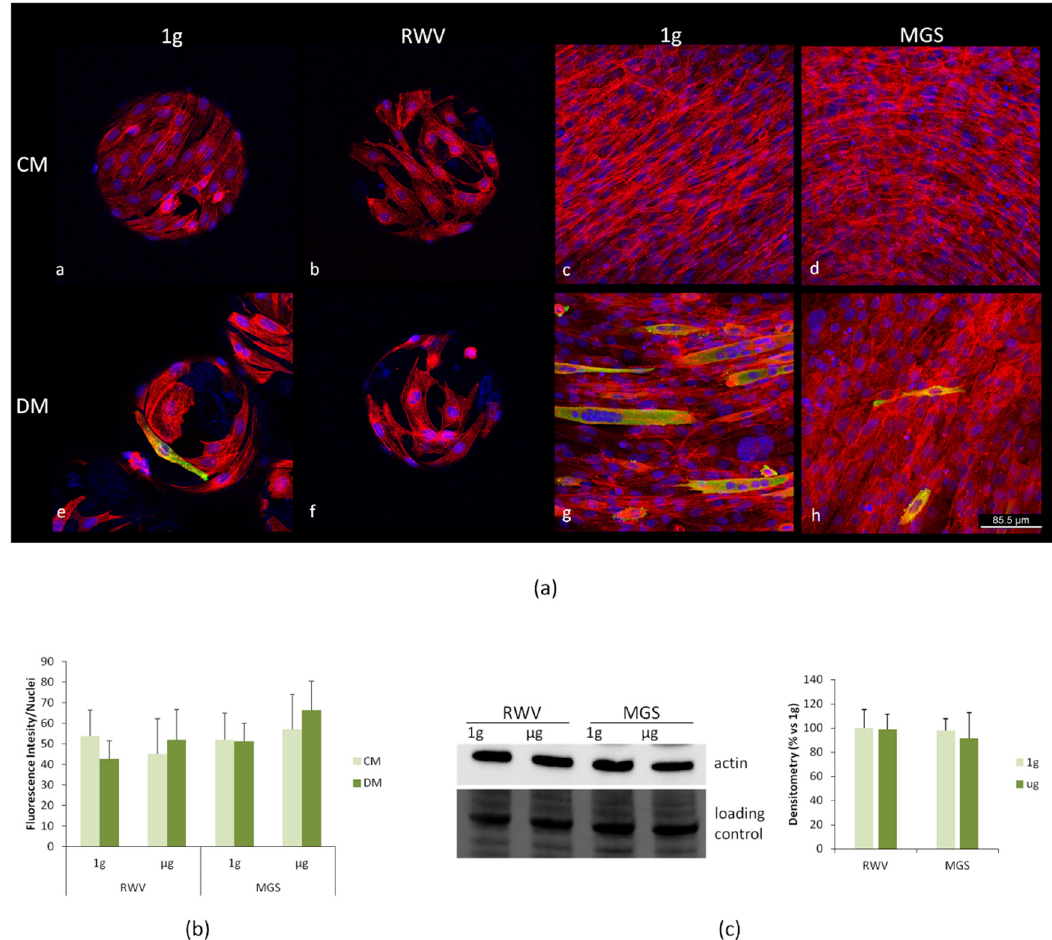
Figure 6. C2C12 were cultured in the RWV and in the MGS or in 1 g-ground control for 4 days. ( a ) The cells were fixed and immunofluorescence was performed using antibodies against myosin heavy chain 3 (MHC). The samples were counterstained with rhodamine labeled phalloidin and 4 ′ ,6-diamidine-2 ′ -phenylindole dihydrochloride (DAPI). ( b ) Phalloidin fluorescence was quantified by ImageJ. ( c ) Cell extracts were analyzed for β -actin levels by western blot, and densitometry was performed using ImageJ.